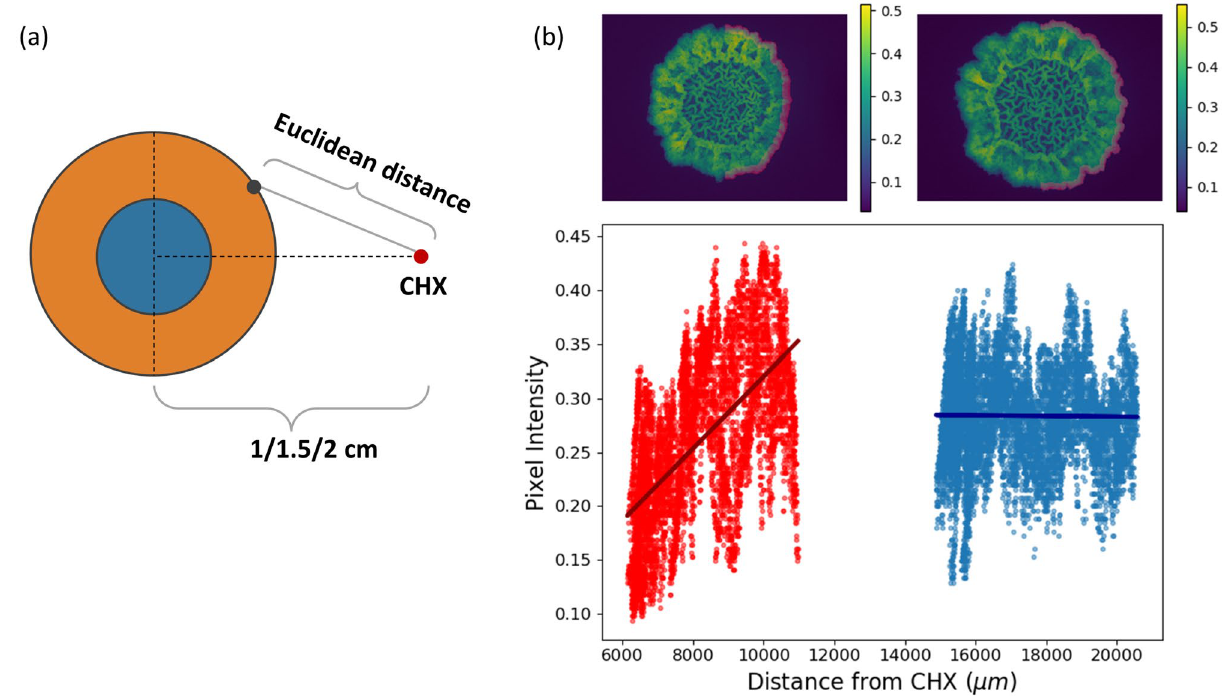
Figure 5. Linear regression model for pixel intensity at the leading edge as function of Euclidean distance from CHX source. ( a ) Illustration demonstrating the distance calculation between the CHX source (red dot) to each pixel within the macrocolony. ( b ) (Top) B. subtilis macrocolonies on day 3 at 1 cm (left) and 2 cm (right) distances from CHX source. (bottom) Intensities of pixels located at the leading edge (highlighted 20 pixels-wide section from the outer rim) of the exposed half of the macrocolony: red pixels originate from 1 cm macrocolony, blue pixels originate from 2 cm macrocolony. Linear regression lines demonstrate that at 1 cm, pixel intensity is correlated to the distance from CHX source, while no such effect is seen at 2 cm